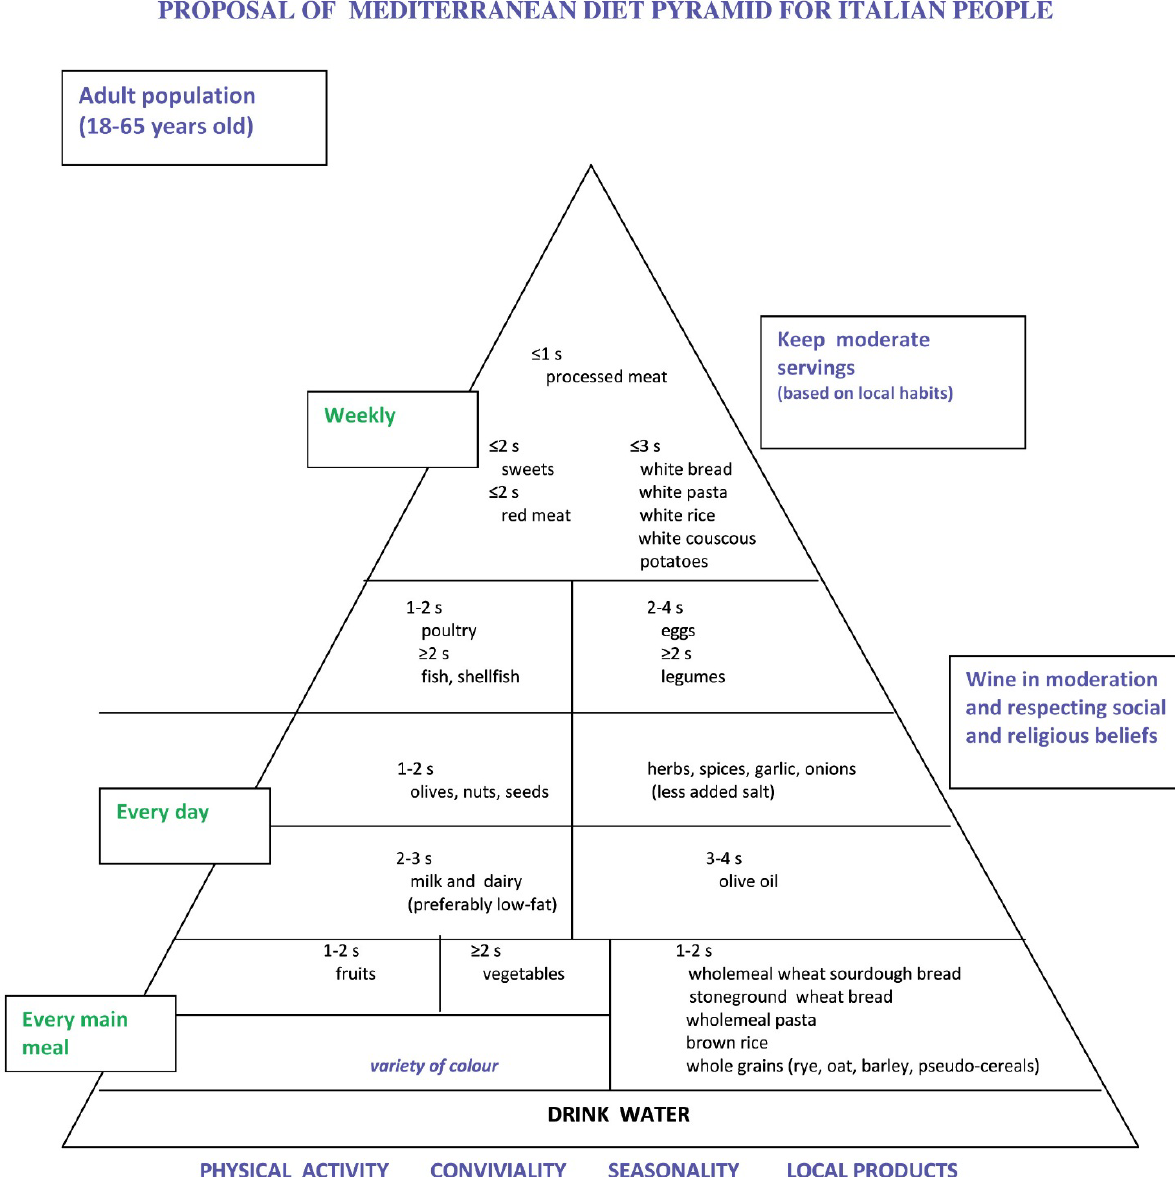
Figure 2. Proposal of the Mediterranean diet pyramid for Italian